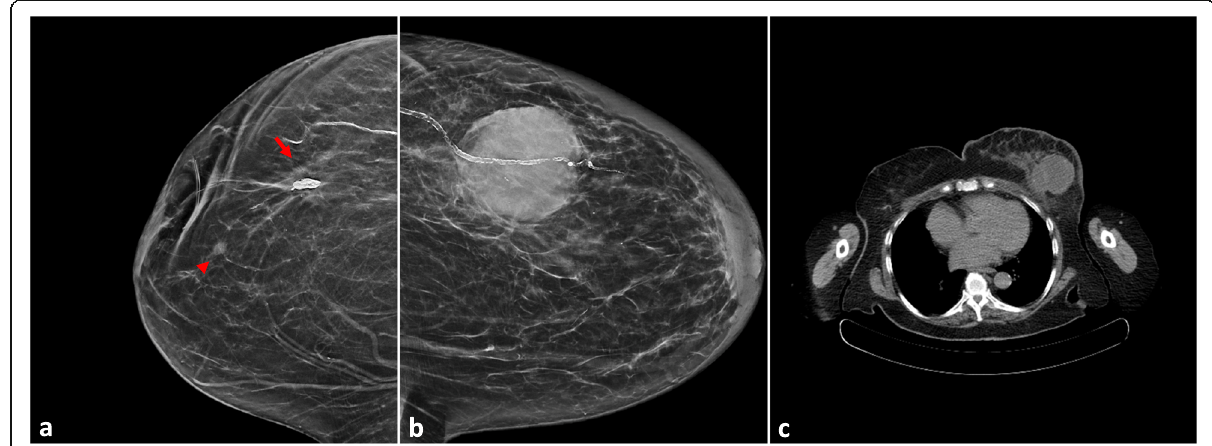
Fig. 1 Radiologic findings. a Mammography for right breast showing a circumscribed subcentimeter mass (arrowhead). Previous surgical site can also be identified (arrow). b Mammography for left breast showing a partly circumscribed mass with thickened overlying skin. No connection between the mass and skin was noted. c Computed tomography scan showing the lesions in both